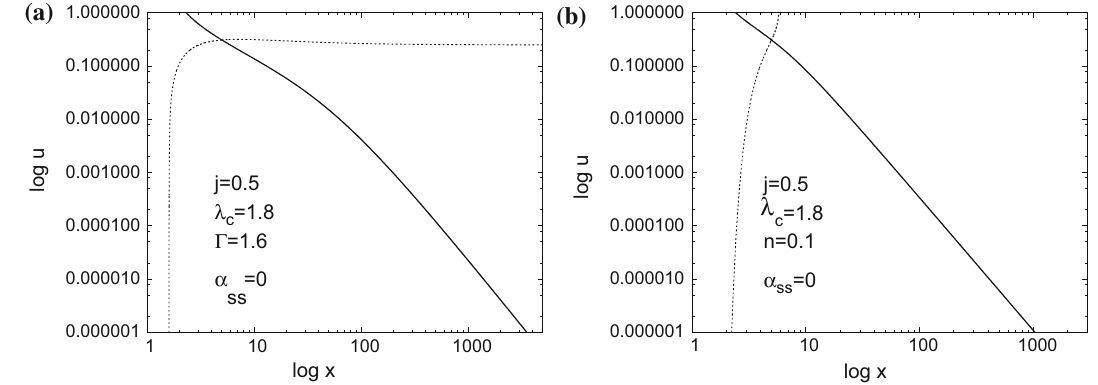
Fig. 4 a , b are plots of log( u ) vs. log( x ) for non-viscous accretion disc flow around a rotating BH (with specific angular velocity j = 0 . 5) for the adiabatic and MCG cases, respectively. Accretion and wind curves are depicted by solid and dotted lines,